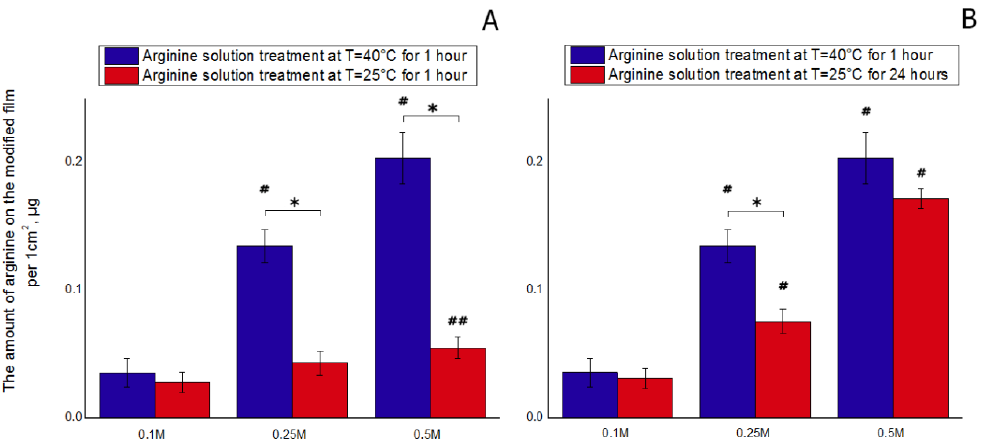
Figure 1. The dependence of the amount of arginine on the modified film per 1 cm 2 on the concentration of the solution at T = 40 °C and T = 25 °C: ( А ) with the same duration of treatment, ( B ) with the maximum duration of treatments (n = 5: *—p < 0.01 for the same concentration data, #—p < 0.01 compared with lower concentration, but the same temperature, ##—p < 0.05 compared with 0.1 M at 25 °C).